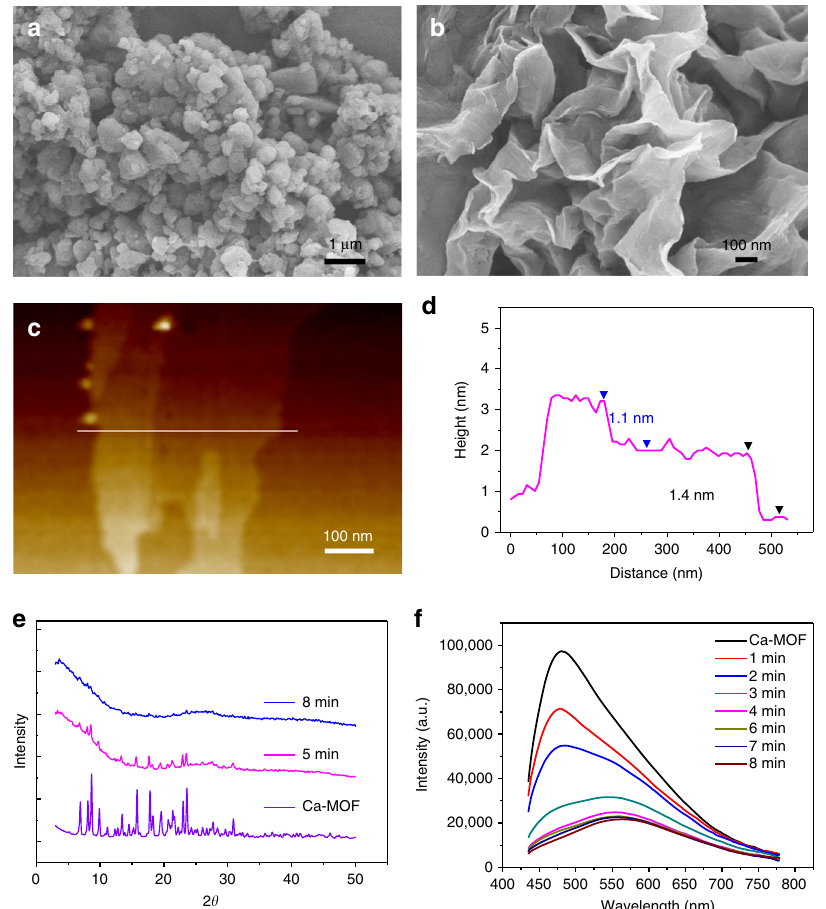
Fig. 5 Grinding exfoliation. SEM images of Ca-MOF bulk crystal samples after grinding for 8 min at RH = 55% ( a ) and RH = 75% ( b ). AFM image ( c ) and height distribution pro fi le ( d ) of NS-2. PXRD ( e ) and emission spectra ( f ) of Ca-MOF after grinding for different time at RH =